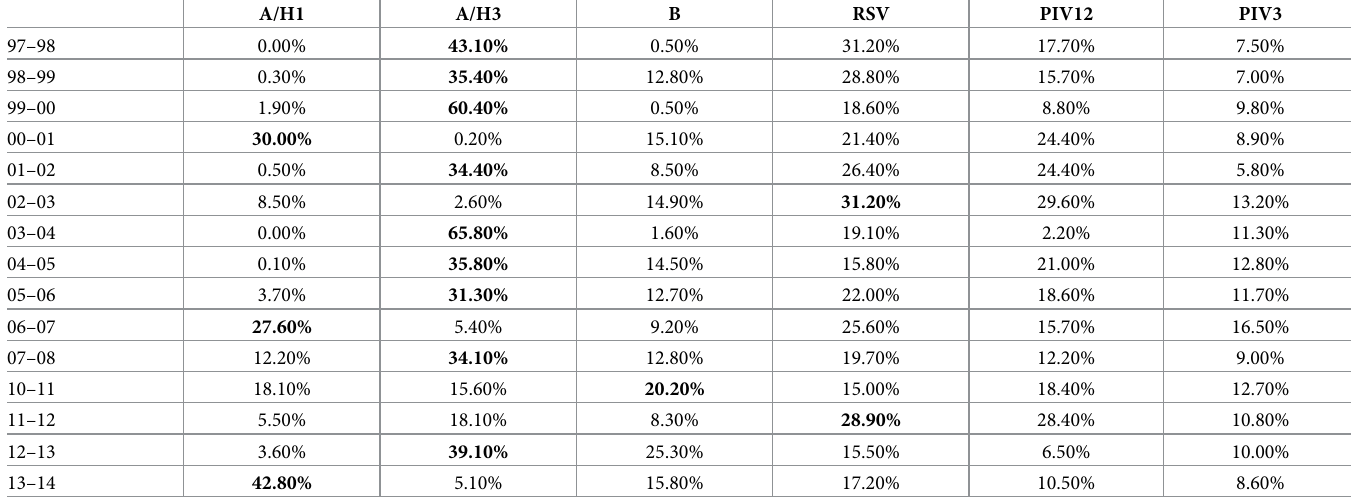
Table 1. Overall contributions of the six pathogens to national ILI in 15 seasons. The contribution of pathogen i is calculated as where v i ( t ) is the observed positivity rate of pathogen i at week t , and w i is the inferred mean multiplicative factor for pathogen i . The inferred dominant pathogen in each season is in